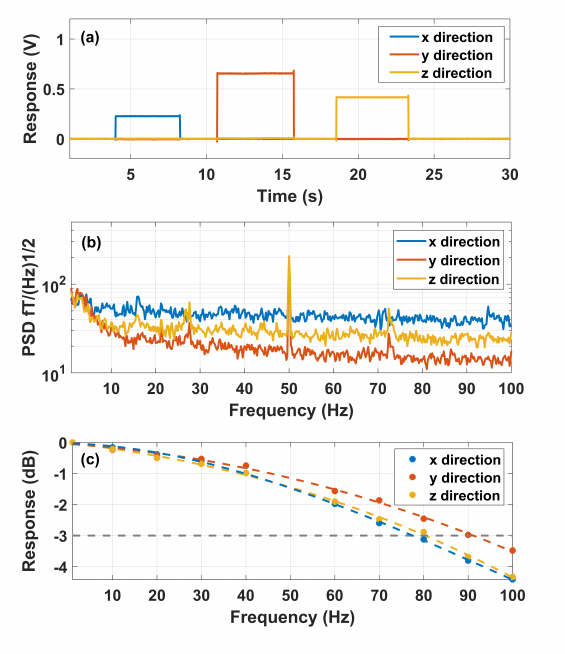
Figure 4. ( a ) Response of the AM to the changes in the magnetic field along three orthogonal directions. ( b ) Triaxial Sensitivity of the AM. ( c ) The frequency responses of the AM in x, y and z